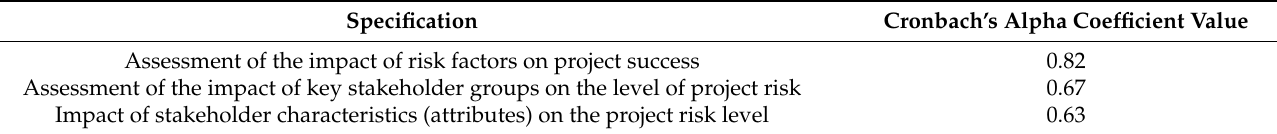
Table 3. Measuring the reliability of the survey